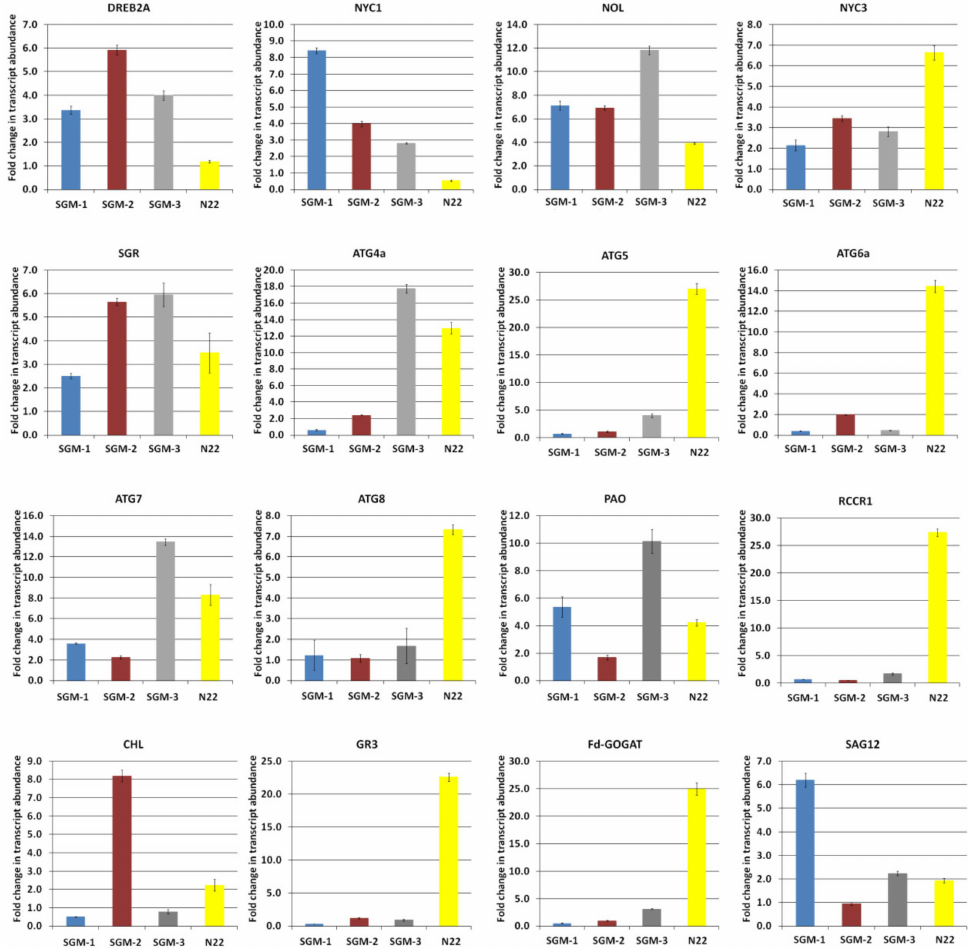
Figure 7. Relative gene expression analysis of DREB2A and 15 genes involved in chlorophyll catabolism, senescence and nitrogen assimilation in three stay-green mutants (SGM-1 to SGM-3) and the wild type, Nagina 22 (N22) under drought